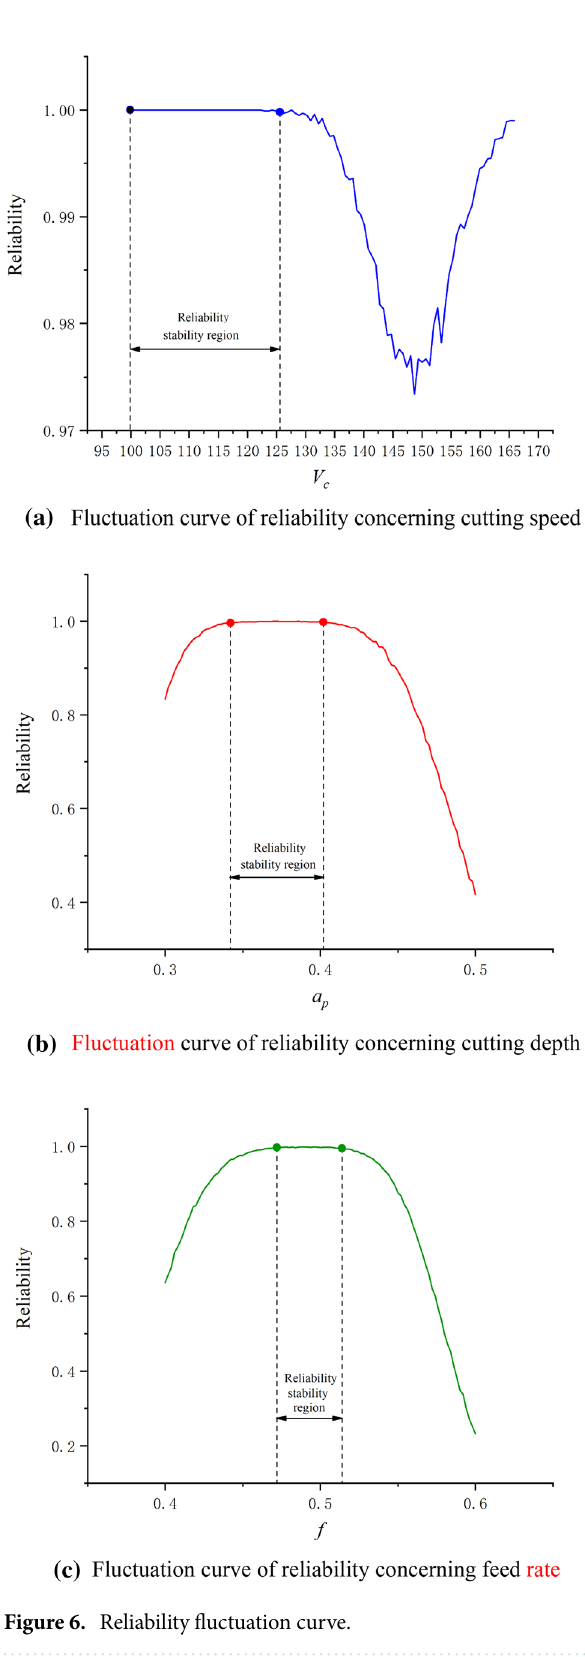
Figure 6. Reliability fluctuation